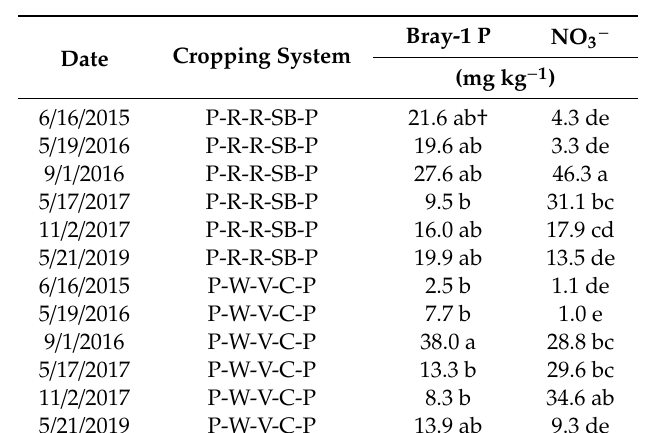
Table 5. Bray-1 P and NO 3 − as a function of the interaction between sampling date and cropping systems in Minnesota site.